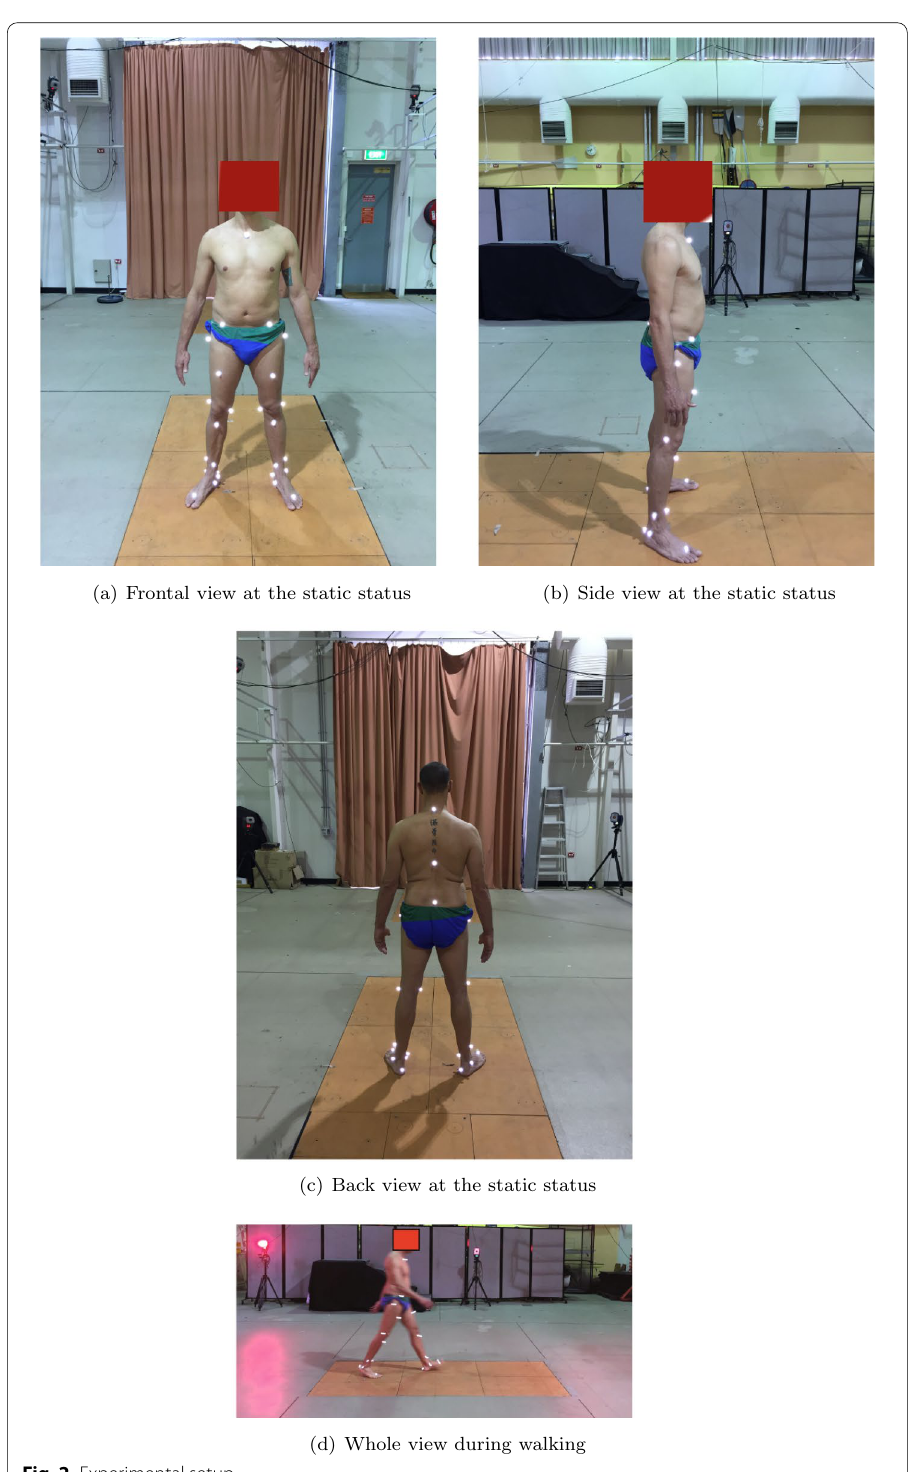
Fig. 2 Experimental